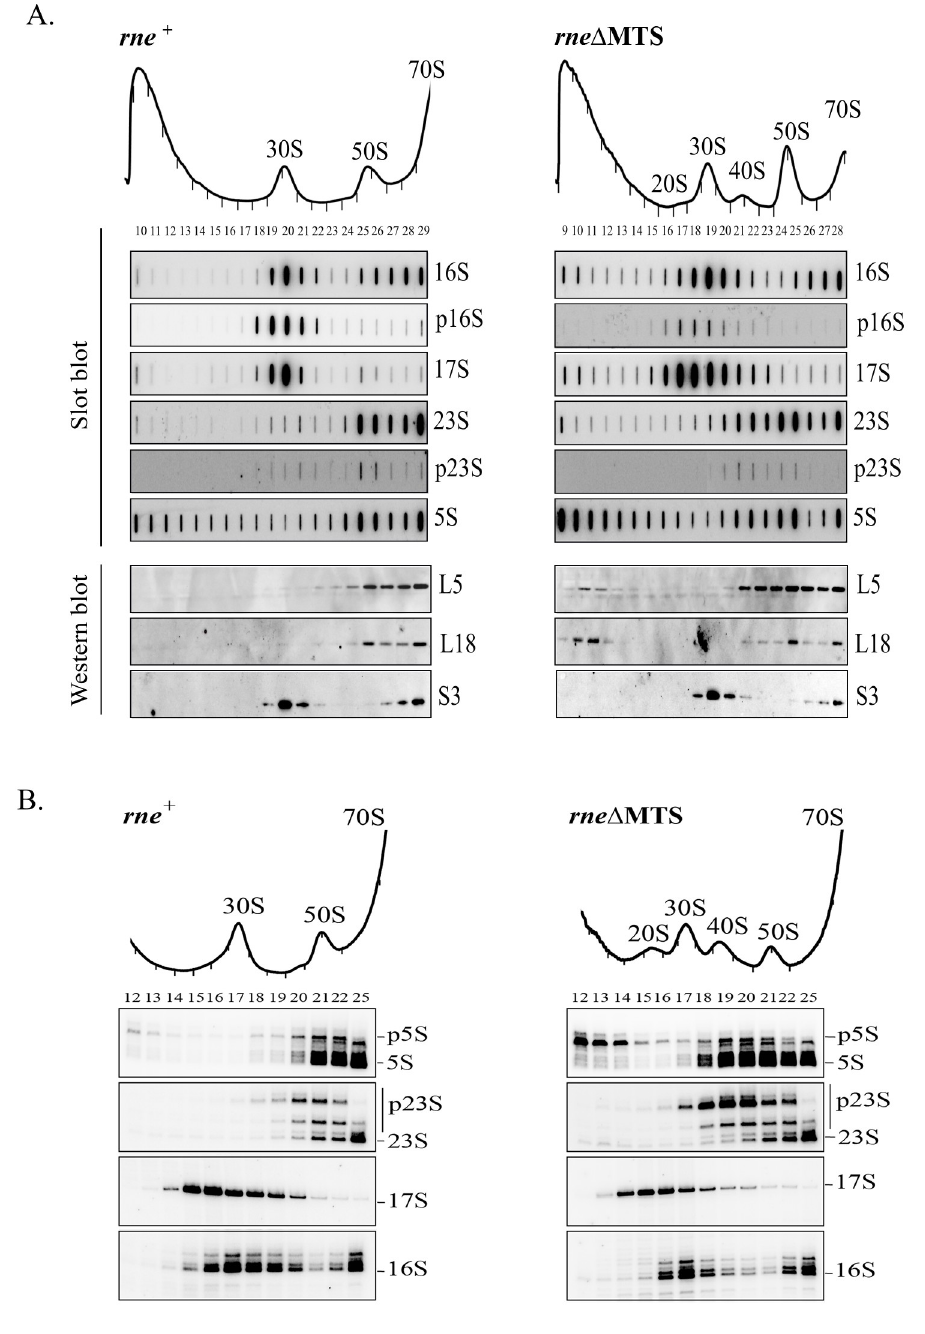
Fig 2. RNA content of ribosomal particles. Equal volumes of clarified cell lysates from rne + (left) and rne Δ MTS (right) strains were fractionated by velocity sedimentation. Conditions were optimized for separation in the range of 20S to 70S. Sucrose gradient fraction numbers are indicated below the UV absorption profiles. (A) RNA from the sucrose gradient (fractions 10 to 29 for rne + strain and fractions 9 to 28 for rne Δ MTS strain) was analyzed by slot blots using oligonucleotides specific to the RNA species indicated to the right of each panel. Protein from the sucrose gradient (fractions 10 to 28 for rne + strain and fractions 9 to 27 for rne Δ MTS strain) was analyzed by western blotting using antibodies against the ribosomal proteins indicated to the right of each panel. (B) RNA from the sucrose gradient fractions was analyzed by primer extensions using [ 32 P] end-labelled oligonucleotides specific to the 5 0 ends of 5S, 23S, 17S, and 16S rRNA. After extension by reverse transcriptase, the products were separated by denaturing